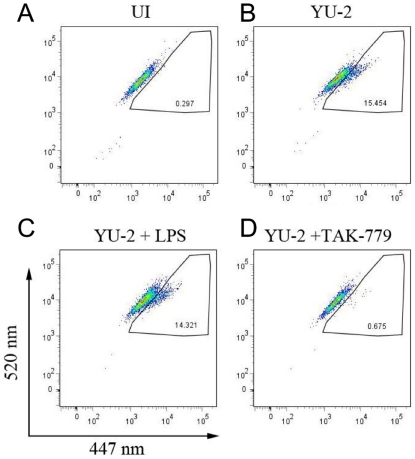
LPS activated MDM permit efficient HIV-1 entry.MDM were treated with vehicle (B) LPS (C), or TAK-779 (D), infected with YU-2-Blam-Vpr, and subjected to flow cytometry as described in Materials and Methods. Uninfected cells (A) serve as negative controls. N = 6.